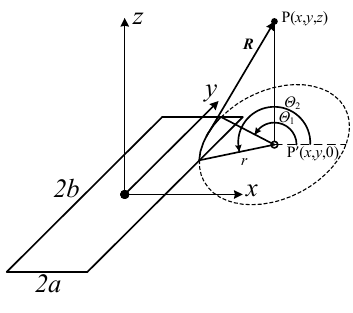
Figure 1. Geometry and coordinate system of the transducer and the field point.